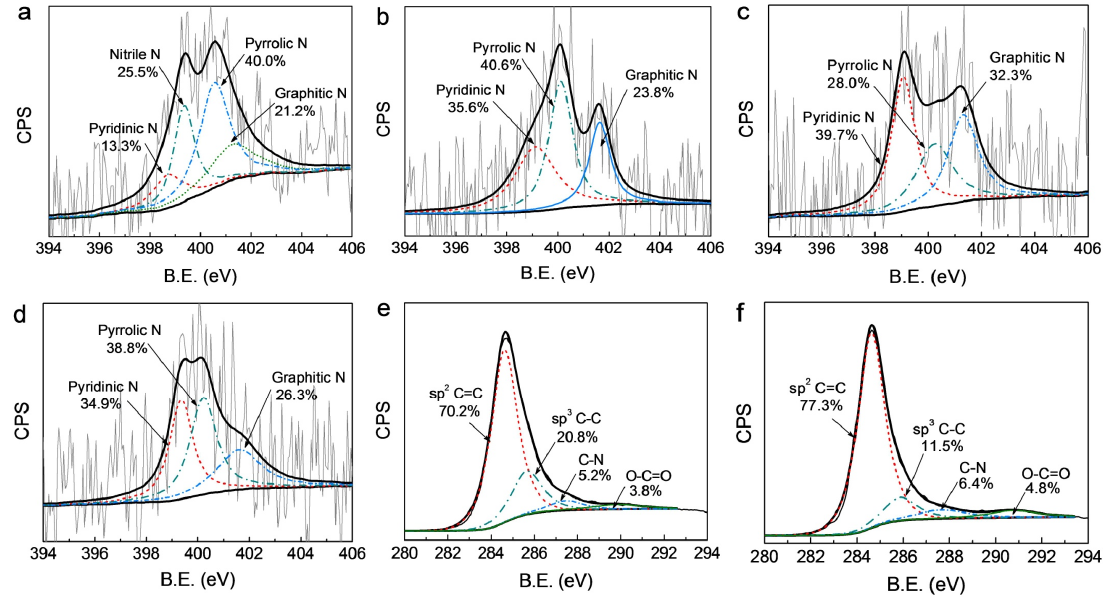
Figure 2. High ‐ resolution N1s XP narrow ‐ scan spectra of EM300 ( a ); N ‐ BC@CNP ‐ 700 ( b